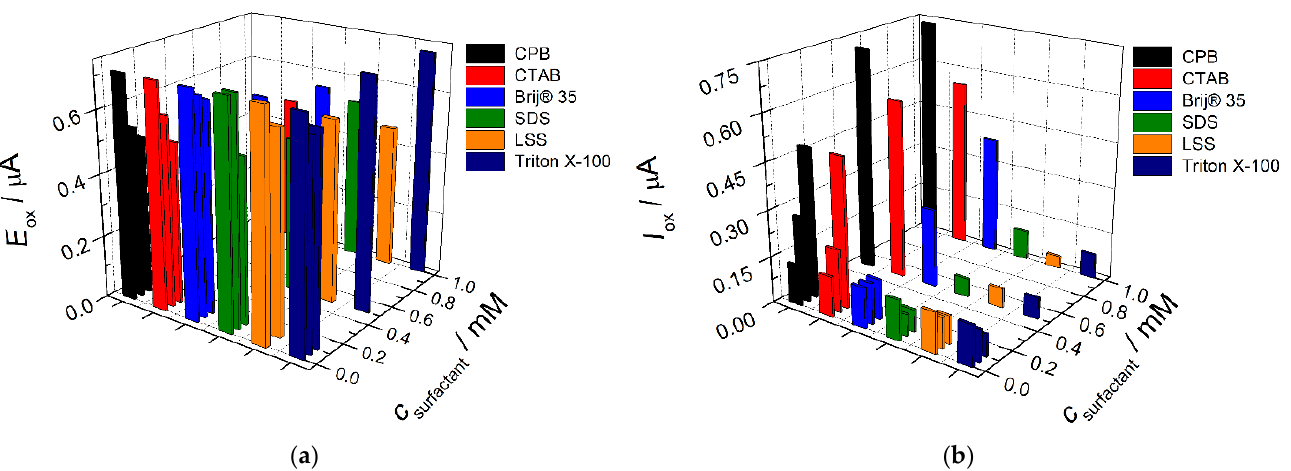
Figure 4. Effect of surfactants on the voltammetric characteristics of 50 µM indigo carmine at the SeO 2 –Surfactant/GCE: ( a ) effect on the oxidation potential; ( b ) effect on the oxidation currents. Supporting electrolyte is 0.1 M phosphate buffer, pH 7.0.